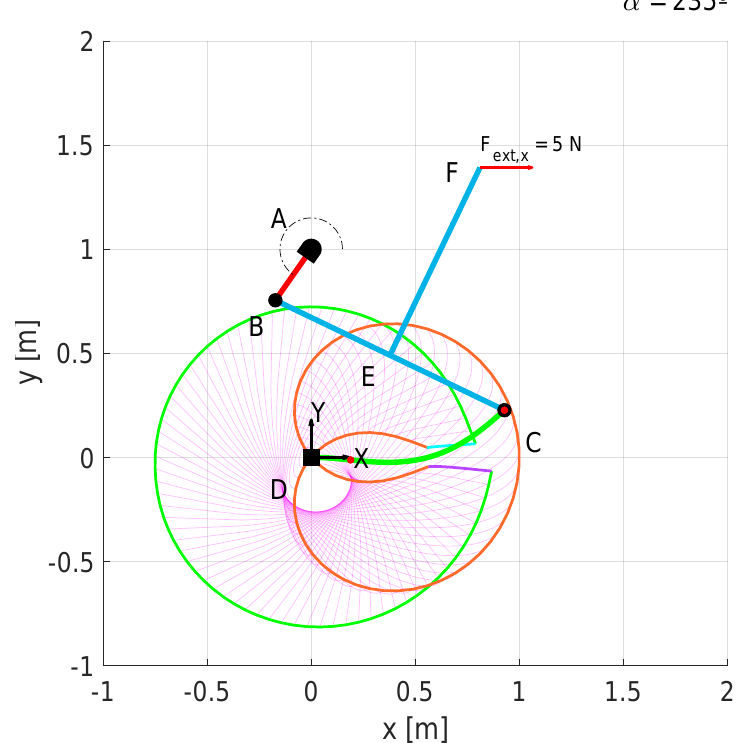
Figure 13. Cycle with buckling mode changes. α = 235 ◦